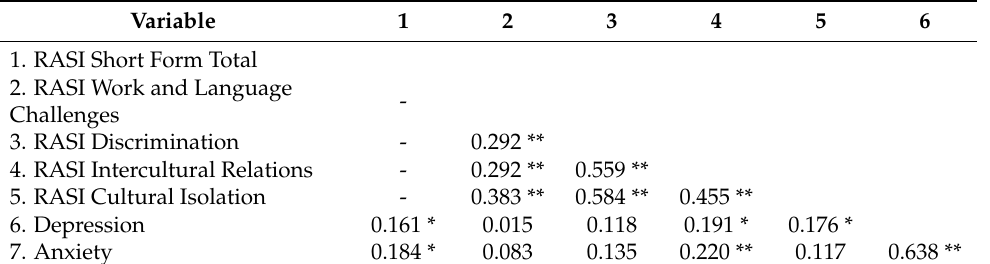
Table 4. Convergent